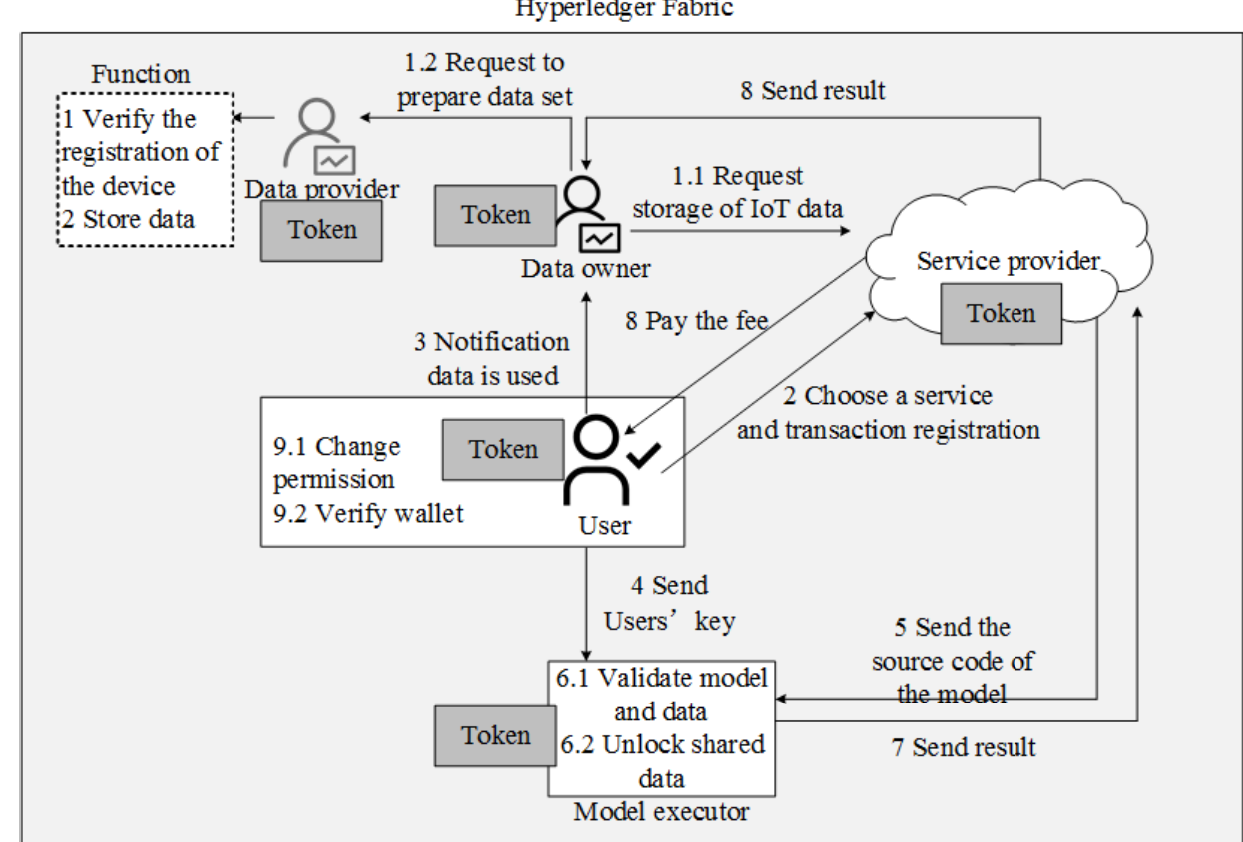
Figure 3. Reconstruction diagram of reference [24].